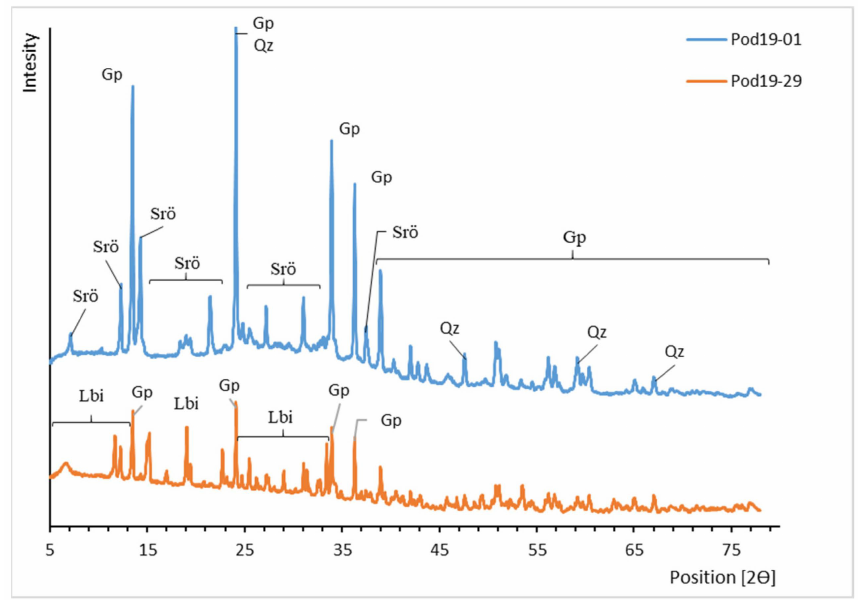
Figure 9. XRD patterns of uranyl carbonates from Podg ó rze mine. Lbi, liebigite; Srö, schröckingerite; Qz, quartz; Gp, gypsum.